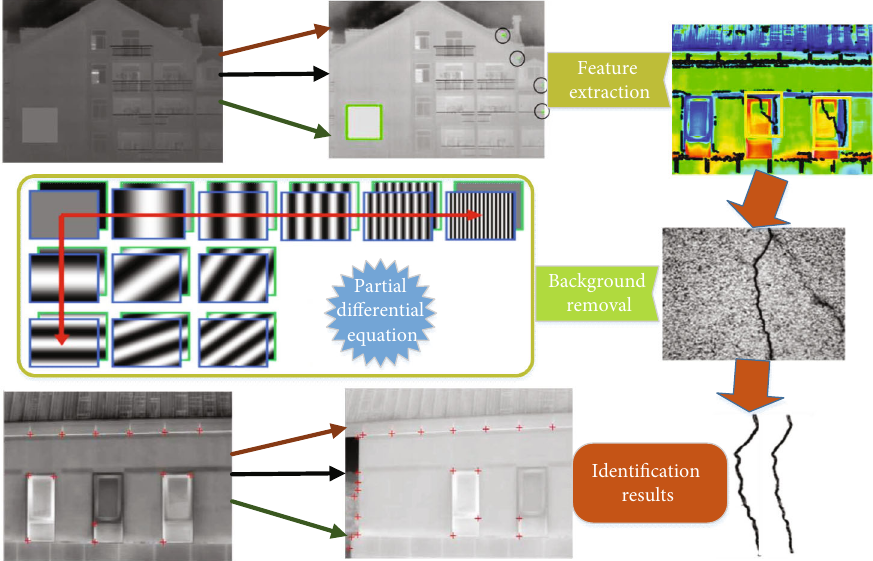
Figure 4: Image defect target recognition results with background.